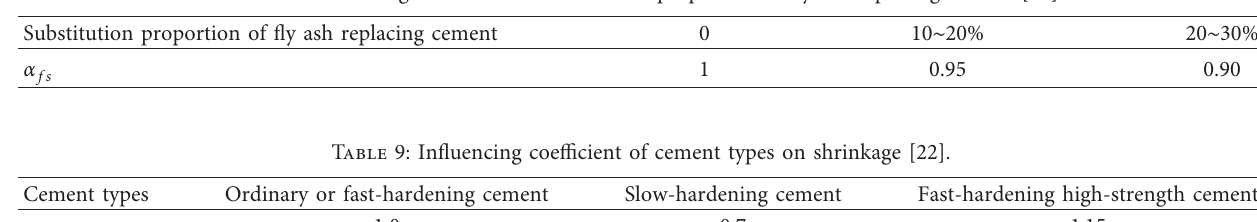
Table 8: Influencing coefficient of substitution proportion of fly ash replacing cement